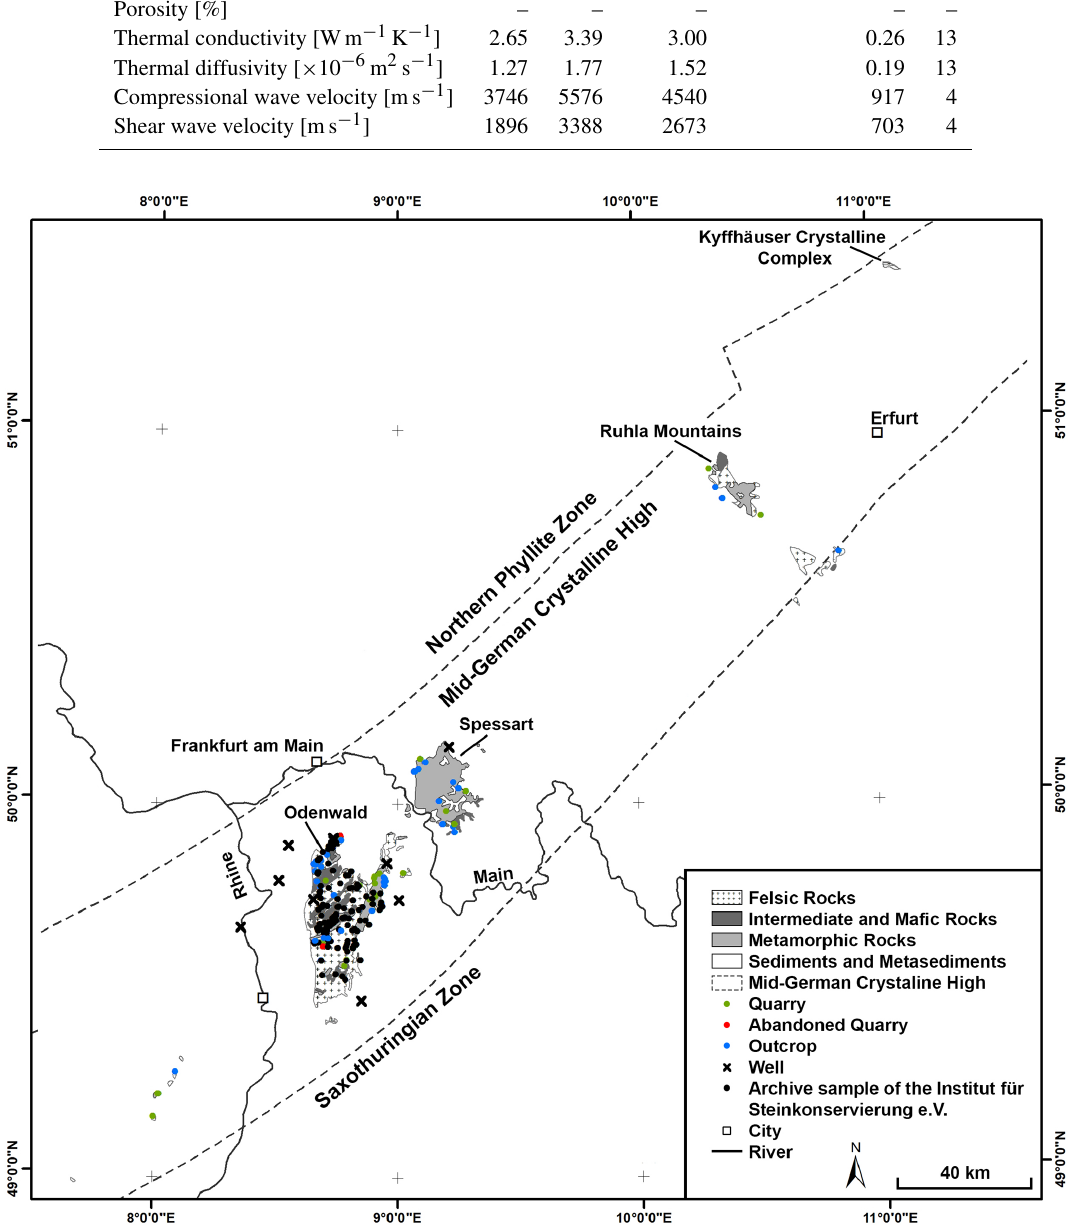
Figure 3. Sampling location of the presented database scattered around Odenwald, Spessart and the Ruhla Mountains as well as well locations and outcrops in the Palatinate Forest. Simplified overview map (after Hirschmann, 1995; Voges et al., 1993; Klügel, 1997; Kroner et al., 2008) of the Mid-German Crystalline Rise outcrops. Sampling locations are from Bär (2008, 2012), Biewer (2017), Dutheillet de Lamothe (2016), Hoffmann (2015), Klaeske (2010), Lambert (2016), Maire (2014), Pei (2009), Rüther (2011), Schäffer (2012), Schäffer et al. (2018), Vogel (2016), Weber (2014), Welsch (2012) and Welsch et al. (2015).